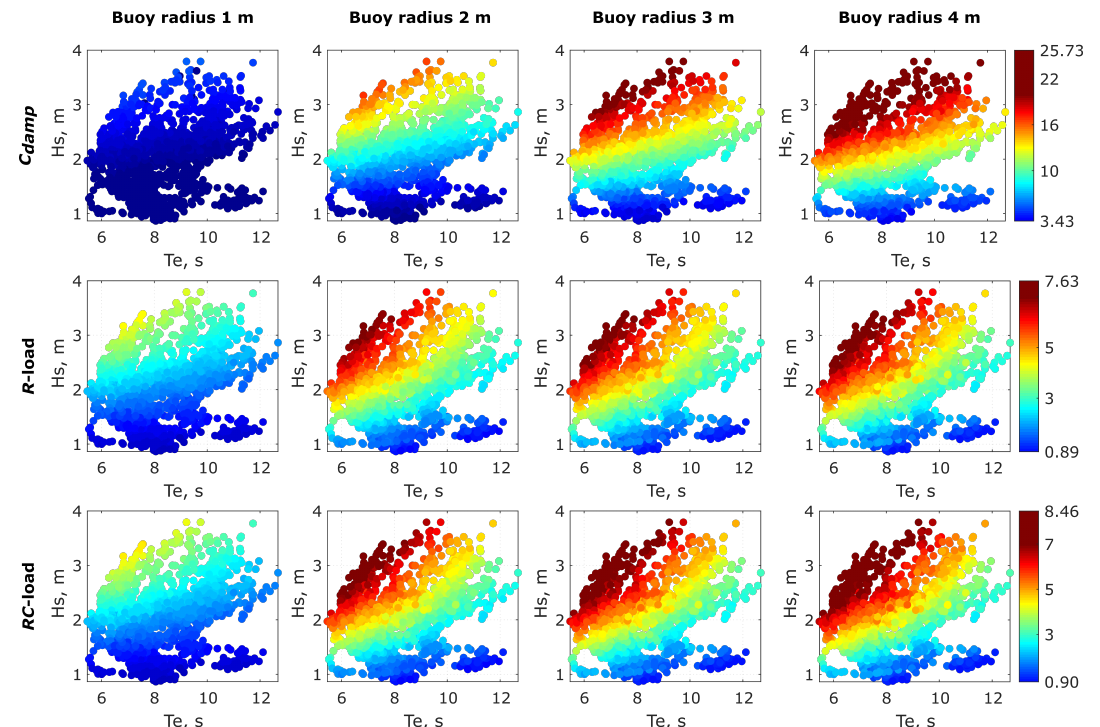
Figure 11. Absorbed power for the slack connection case, calculated for March 2018 wave data. The colour bar shows the average absorbed power in kW.